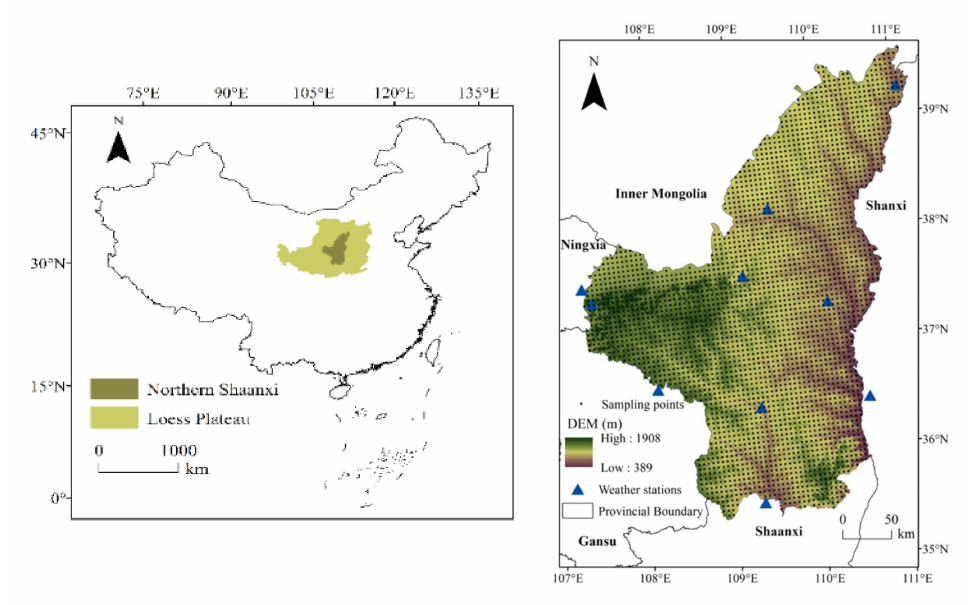
Figure 1. Location of the study